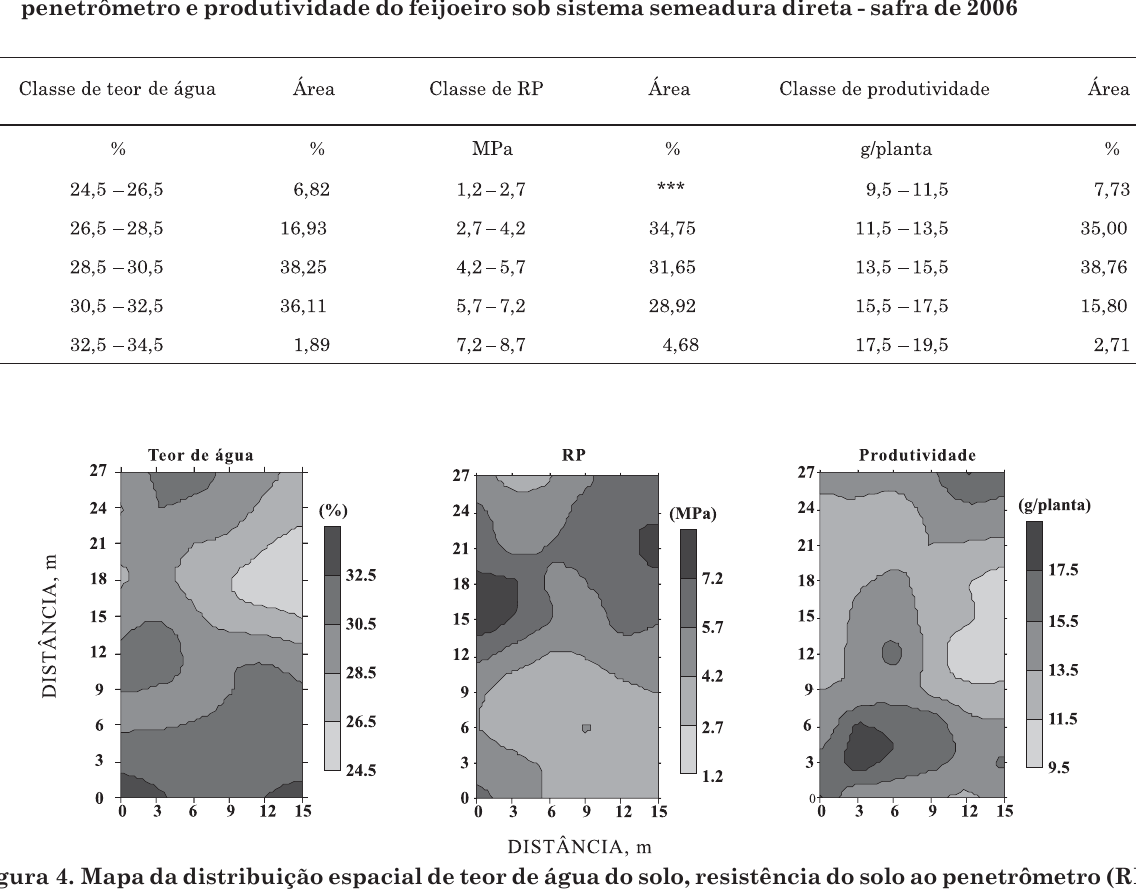
Figura 4. Mapa da distribuição espacial de teor de água do solo, resistência do solo ao penetrômetro (RP) e produtividade do feijoeiro sob sistema semeadura direta – safra